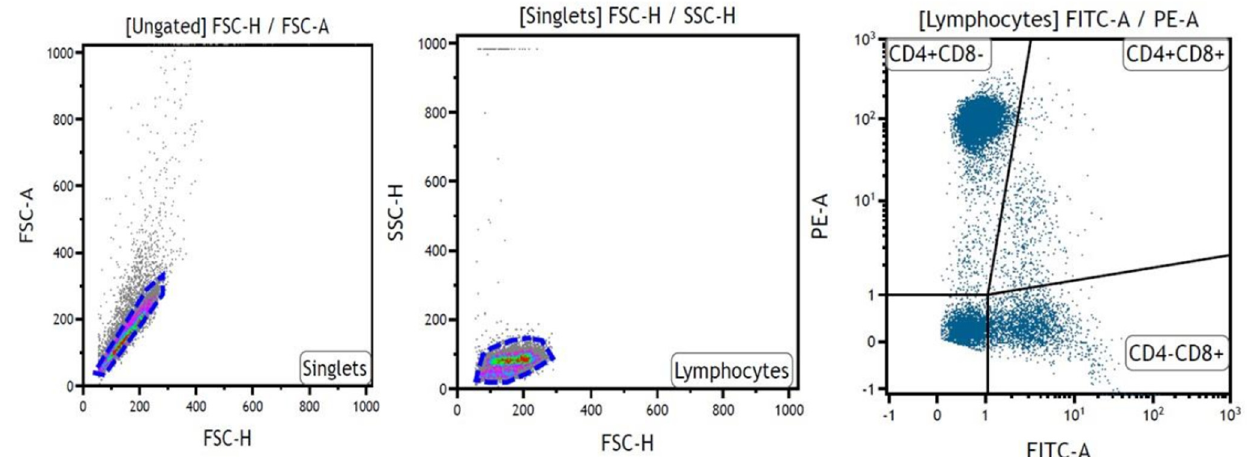
Figure 5. Example of lymphocyte gating strategy for CD4 and CD8 labelling. Doublets were removed from the analysis by setting the gate on single cells on the FSC-area (FSC-A) vs. FSC-high (FSC-H) dot plot. Next, the lymphocytes were gated based on FSC and SSC dot plots. Then, analysis of CD4+ and CD8+cells was conducted.